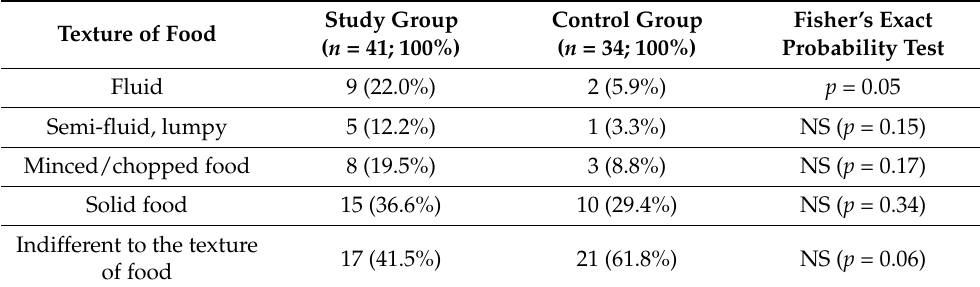
Table 10. Textures of food preferred by the children in the Study Group and the Control Group (question II/15).